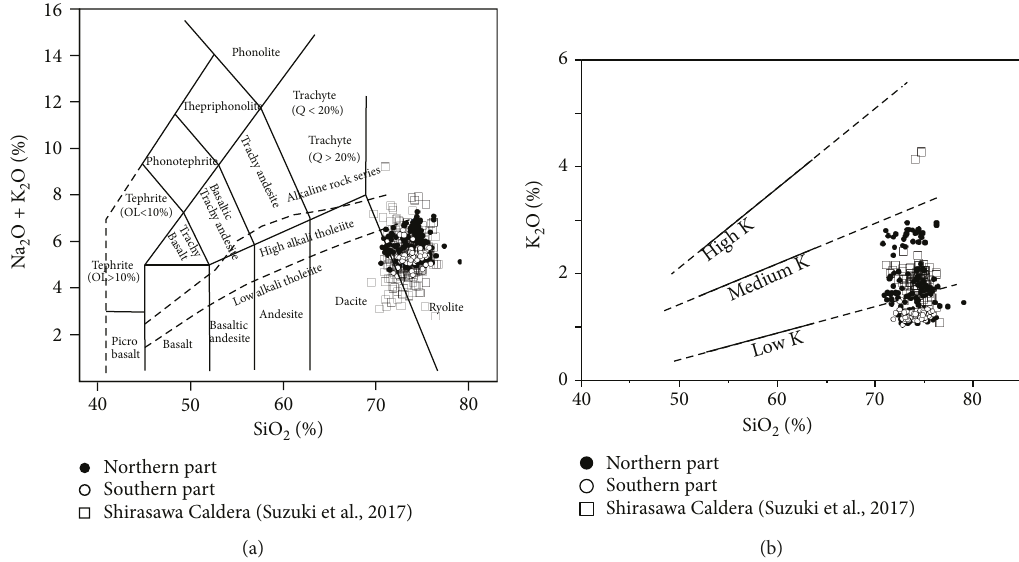
Figure 3: (a) Total alkalis vs. silica (TAS) diagram [35] and (b) SiO from the northern and southern parts of Fukano Caldera, compared with data for Shirasawa Caldera [23]. Ol: olivine; Q: